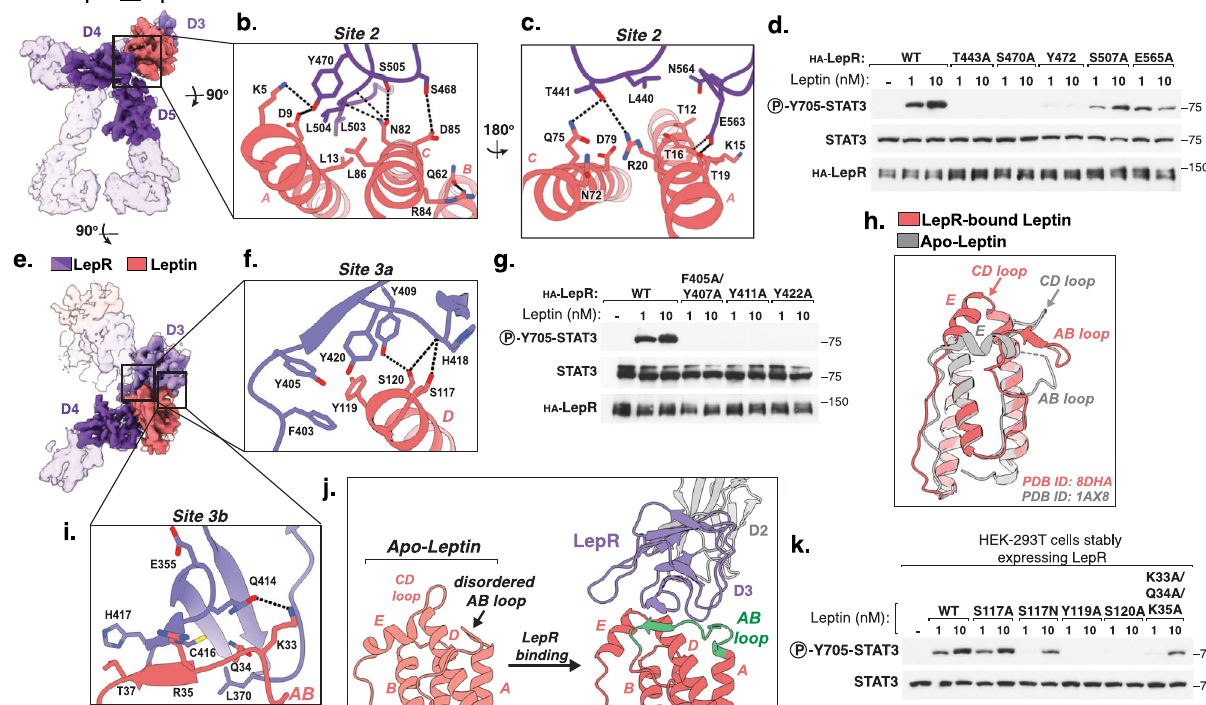
Fig.3|Structuralbasisforleptin-dependentLepRdimerization.a Frontviewof the segmented density map of the leptin-LepR D3-D7 complex resolved to 4.5Å resolution (transparent) with the focus re fi ned map encompassing leptin and the leptin-binding domains of LepR, resolved to 3.8Å resolution (solid). b , c Close-up views of the leptin-LepR site 2 binding interface. Hydrogen bonds and salt-bridges areshownasblackdashed-lines. d ImmunoblotoflysatespreparedfromHEK-293T cells transiently expressing the indicated LepR constructs and stimulated with the indicatedconcentrationofrecombinant leptinfor20min. Representative resultof experiment performed two times. e Top view of the segmented density maps